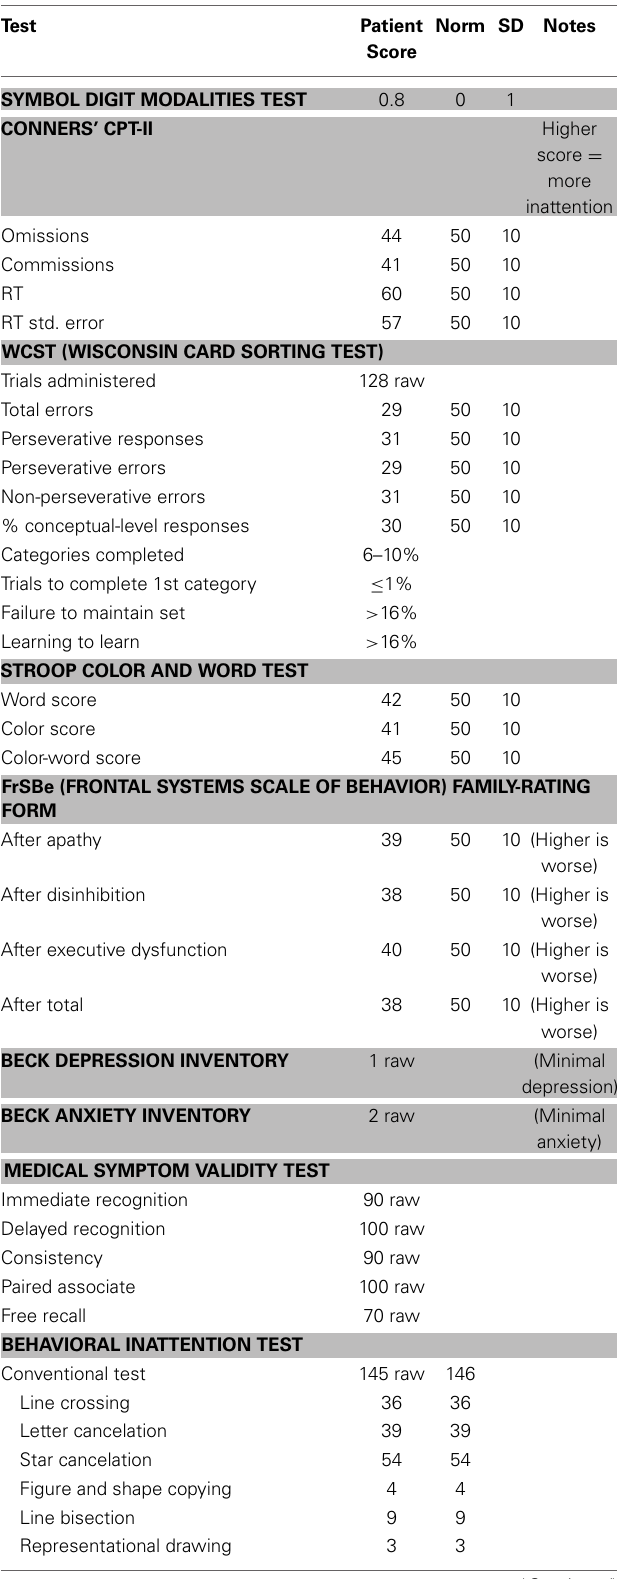
Figure 2A ). Three different trial types were presented to sub- jects in blocks. On Predictive-Cue trials, participants were shown a central arrow cue that predicted with 90% validity the loca- tion of a subsequent peri-threshold Gabor patch. Trials began with a 250 ms white fixation spot at the center of the